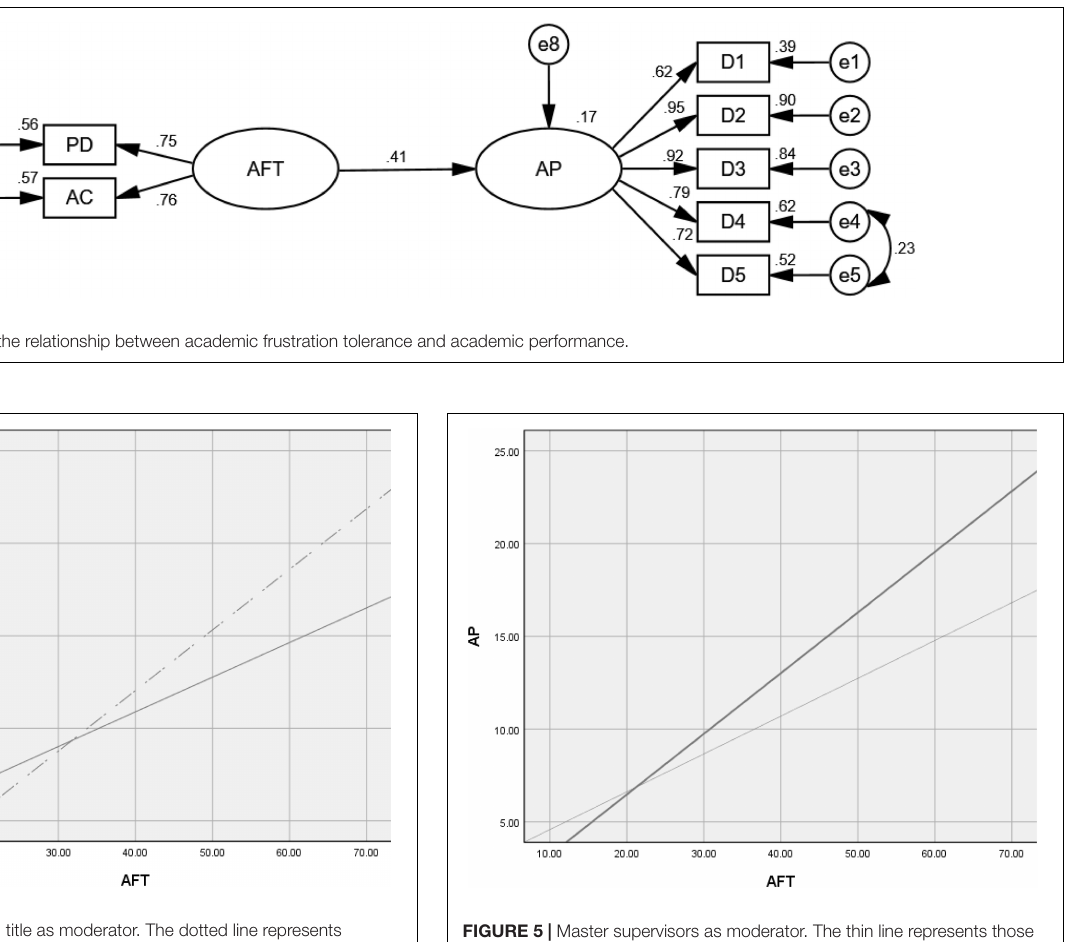
FIGURE 5 | Master supervisors as moderator. The thin line represents those who are not master supervisor ( R 2 = 0.149), and the thick line represents the master supervisors ( R 2 =